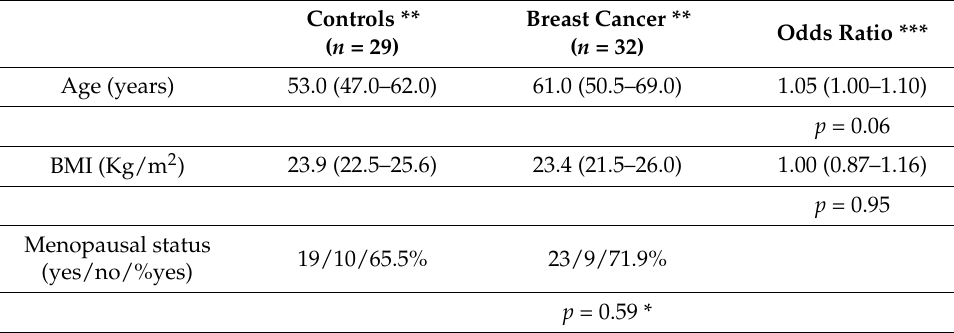
Table 2. Main characteristics of the studied population.